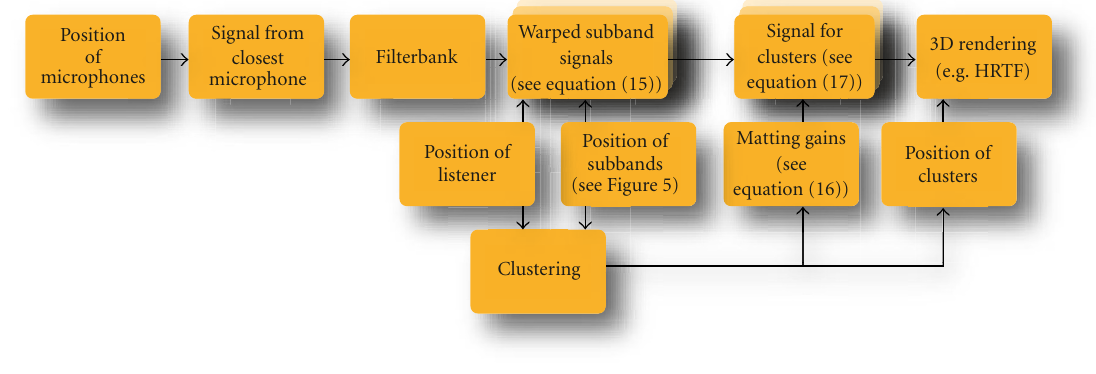
Figure 10: Overview of the synthesis algorithm used to rerender the acquired soundscape based on the previously obtained subband posi-